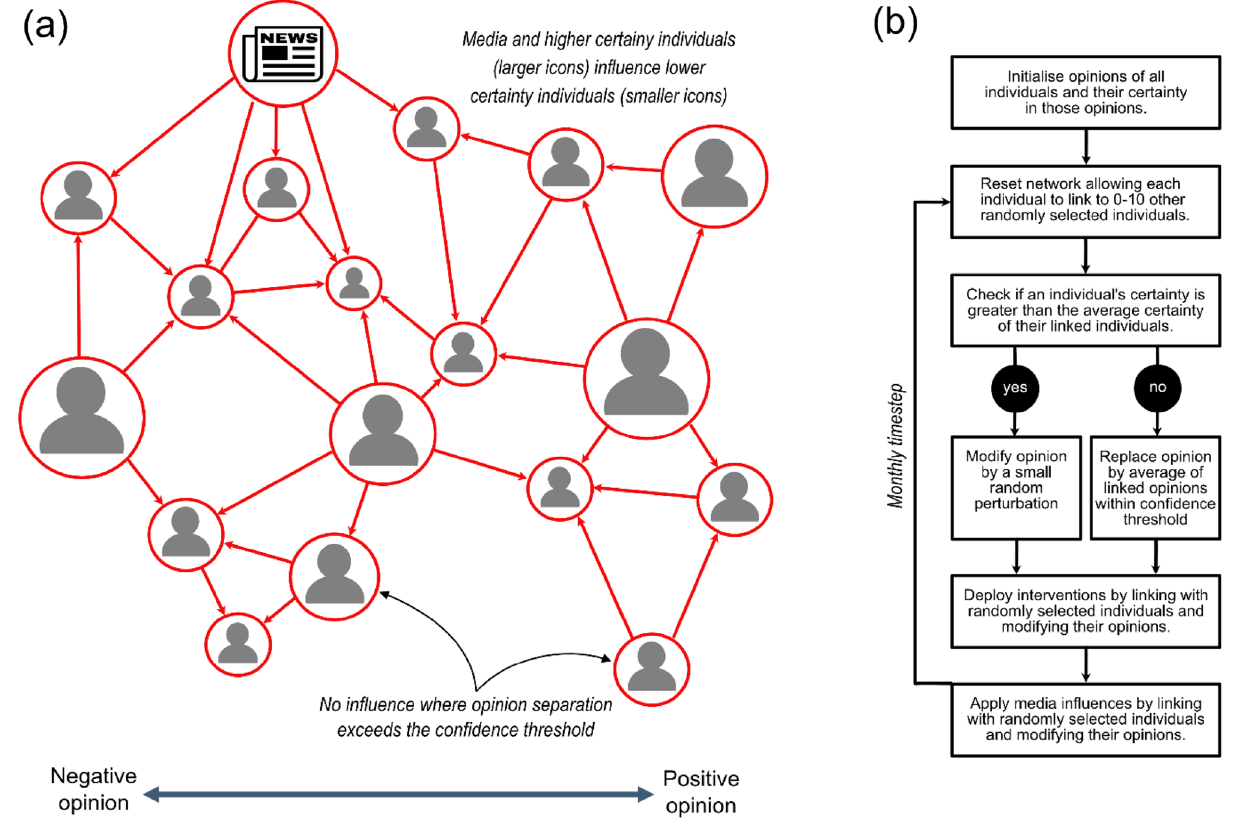
Figure 1. ( a ) Basic network structure of the Social Influence and Events Model (SIEM). The opinion of an individual can potentially be influenced by media or other individuals with higher average certainty (larger icons) and opinions that fall within their confidence threshold (separation of icons). Because homophily is a system characteristic, confidence threshold is the same for all individuals, whereas opinion and certainty vary between individuals. ( b ) Processes simulated in SIEM on a monthly